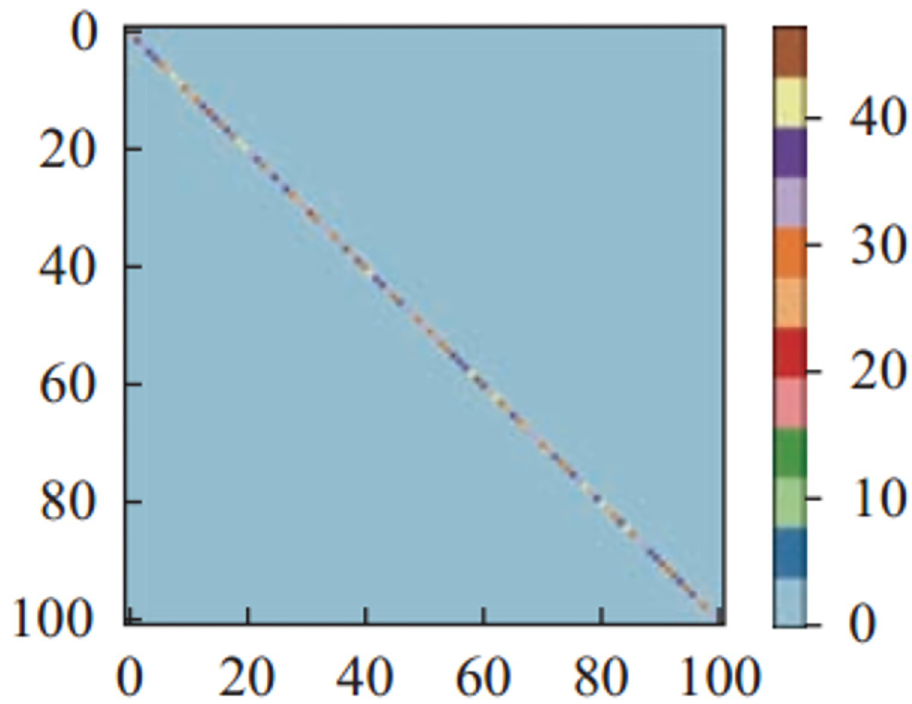
Fig 12. The confusion matrix of the first sectionalization in UCF-101 under the input cropped & original image.